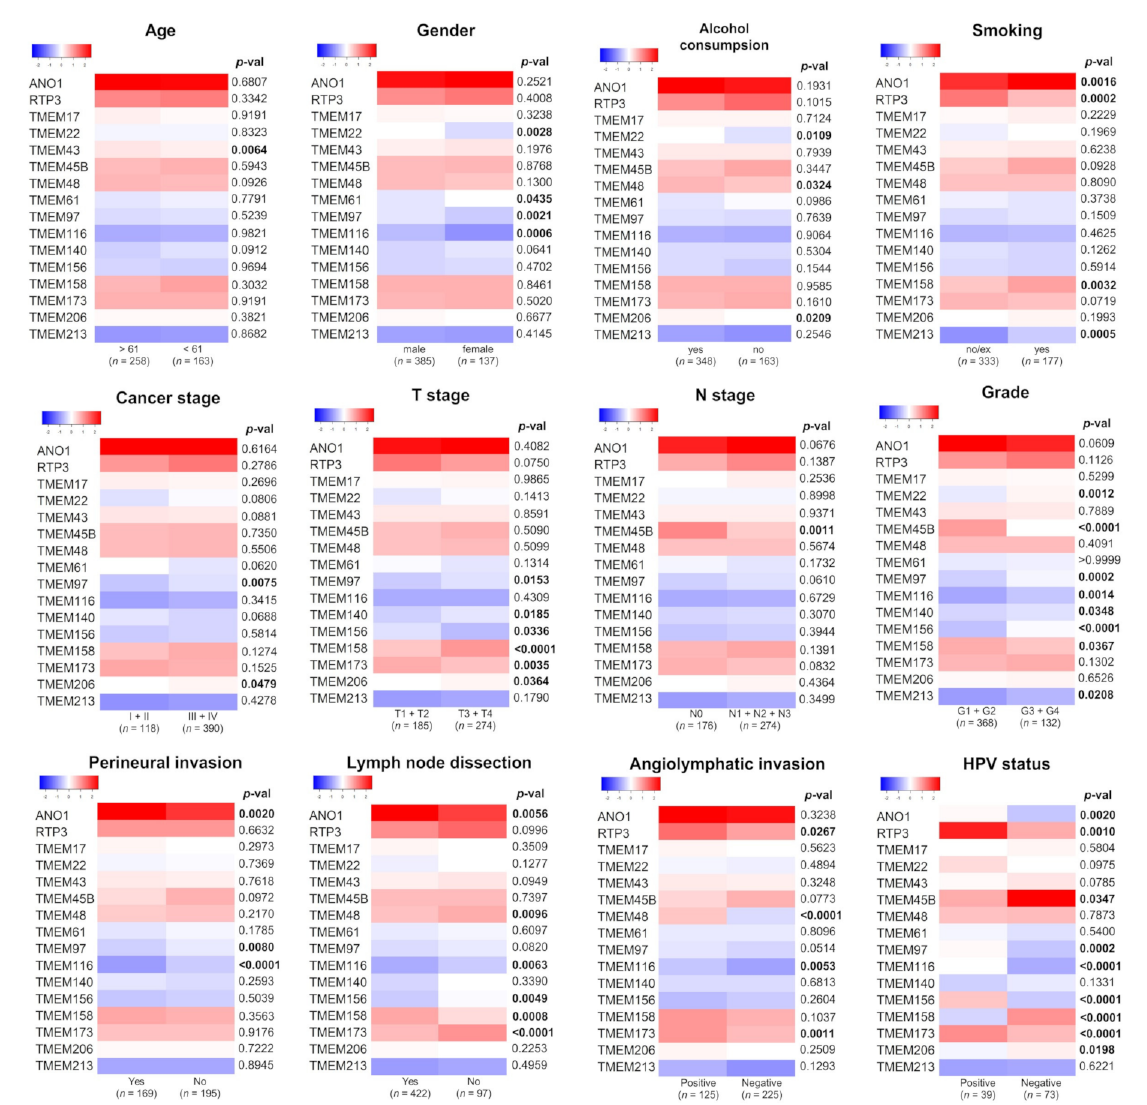
Figure 2. Comparison of selected TMEM s expression depending on clinicopathological parameters in patients with HNSCC. Significantly changed p -values ( p < 0.05) were bolded; n —number of cases in each